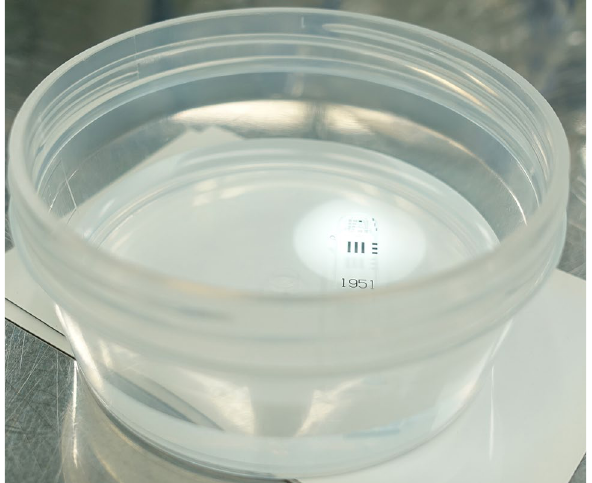
Figure 1. Schema of the in vitro analysis. A transparent 4 cm diameter laboratory dish is placed on white paper, and a 1951 United States Air Force (USAF) test grating target printed on the glass plate is placed on the bottom of the dish. The coaxial light source with 0-degree illumination of the operating microscope was used to illuminate the grating